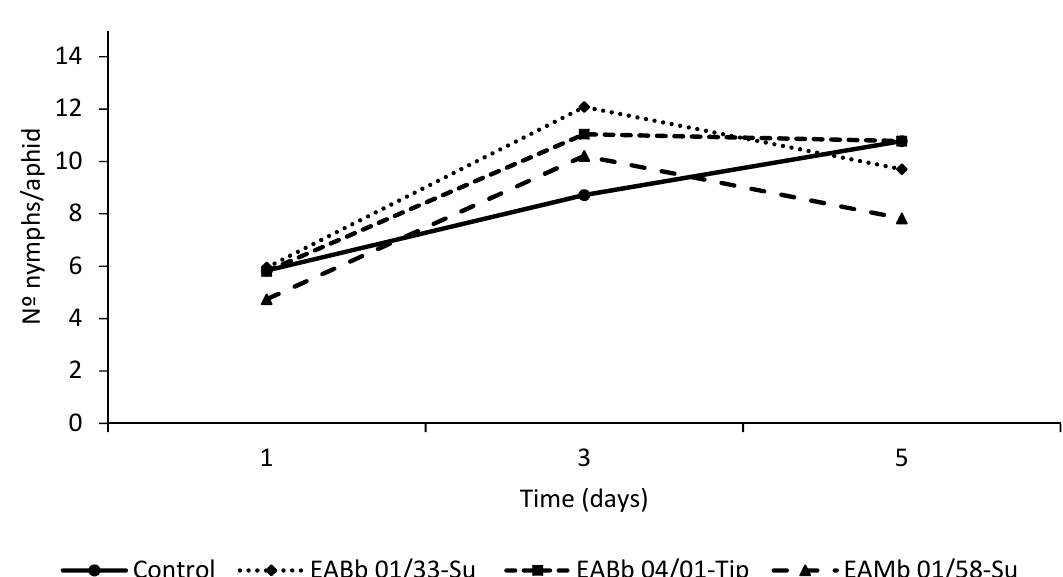
Figure 3. Per capita aphid fecundity over time (5 days) after exposure to an unsprayed leaf (endophytically-colonized by one of three fungal isolates or the control). Evaluation began (day 1 on graph) 72 hours after leaves had been sprayed. Data represents the average of two trials.